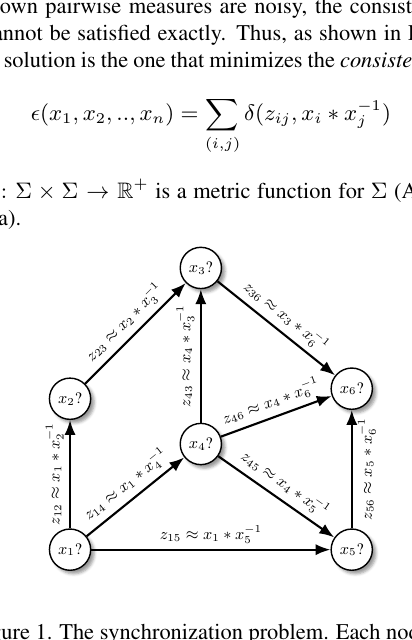
Figure 1. The synchronization problem. Each node is characterized by an unknown state and measures on the edges are ratios of states. The goal is to compute the states that best agree with the